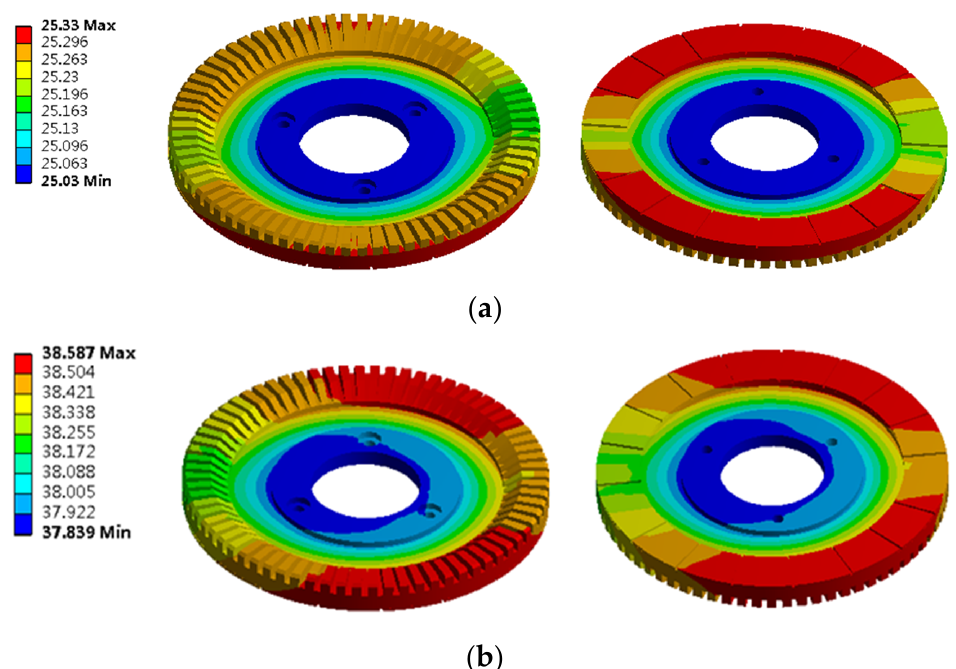
Figure 15. Contour map of piezoelectric stator temperature: ( a ) 20 s temperature contour map; ( b ) 30 min temperature contour map.